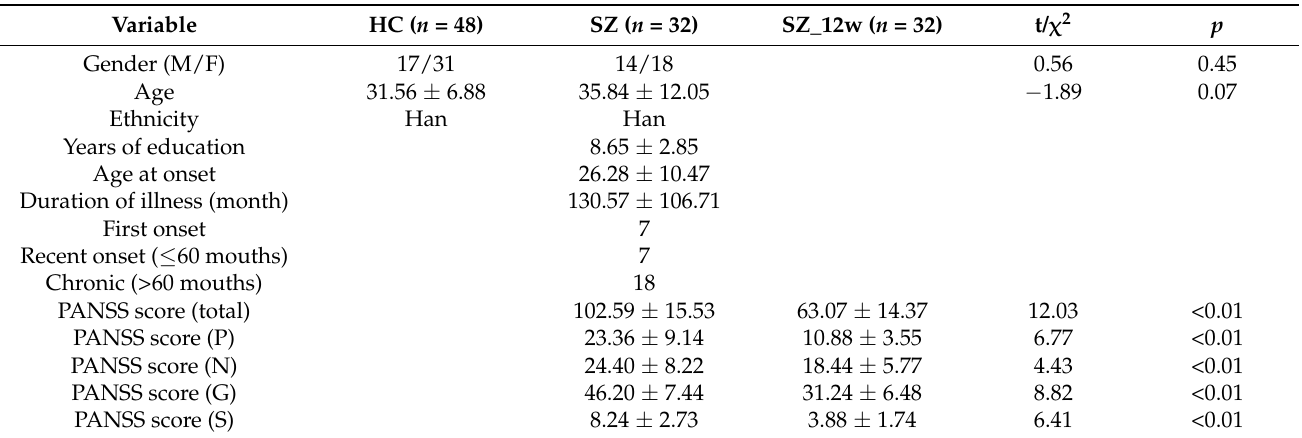
Table 1. Demographics of SZ patients and healthy